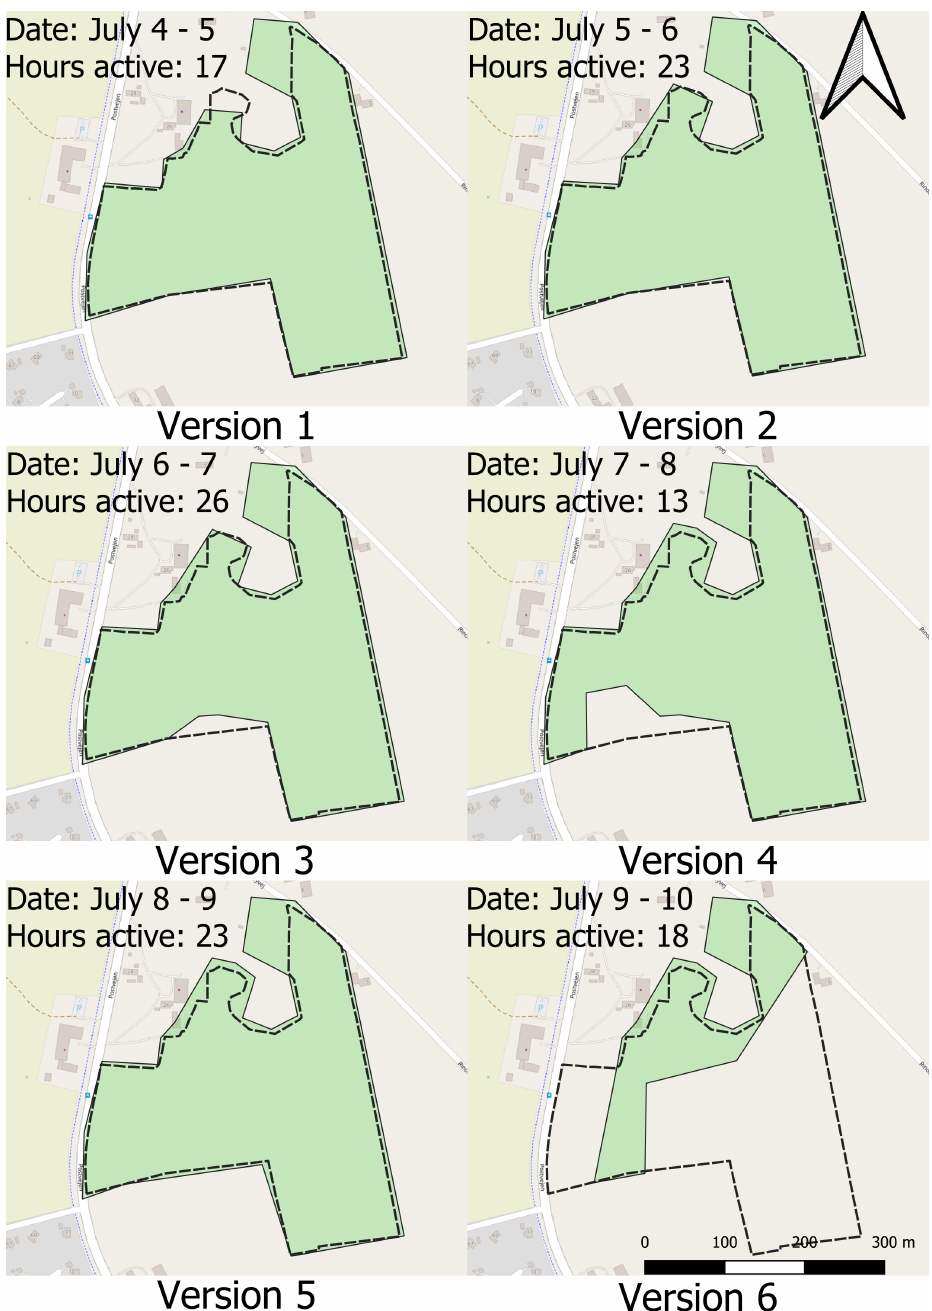
Figure A1. Virtual enclosure version 1 dating from 4 July to 10 July. The dashed black line represents the physical fence surrounding the 8.2 ha grazing area. The marked green area represents the virtual enclosure. Only virtual enclosures active for more than 12 h were included. The coordinates of the up- per left corner of the map frame are 55°25 (cid:48) 23.131 (cid:48)(cid:48) E 8°23 (cid:48) 53.531 (cid:48)(cid:48) N. Map data from OpenStreetMaps